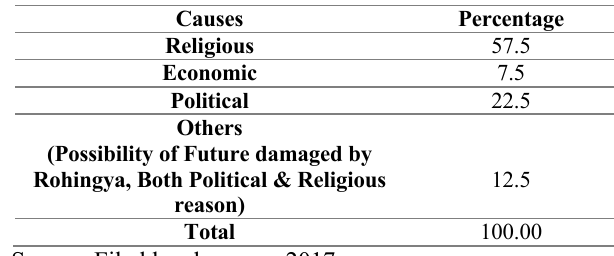
Table 5: Causes of Rohingyas Persecution